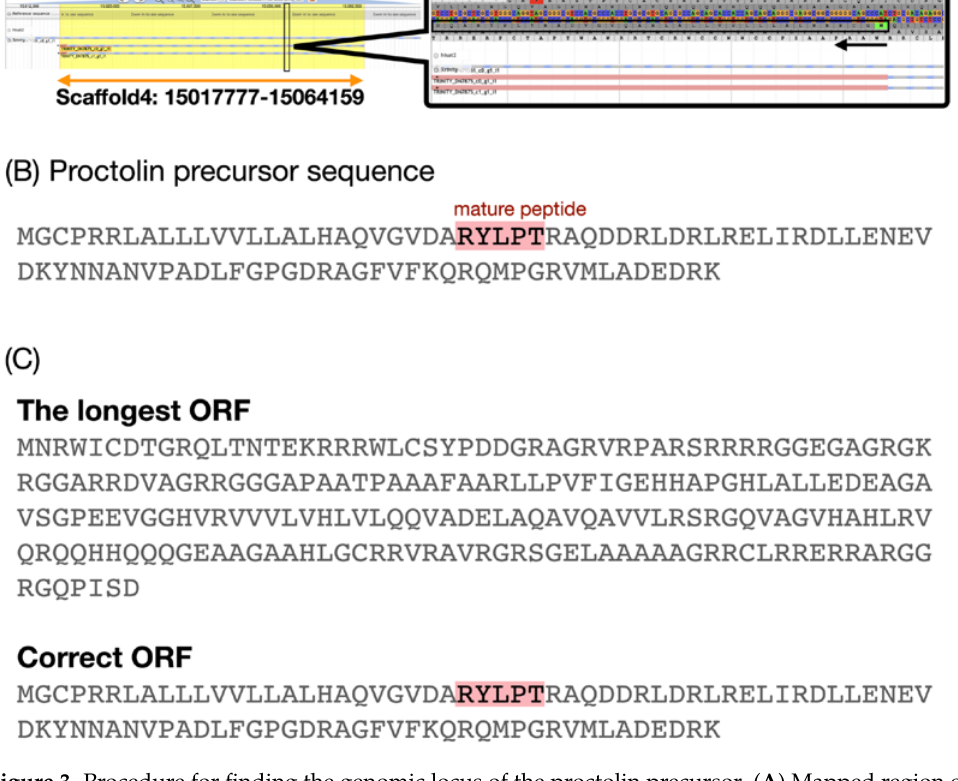
Figure 3. Procedure for finding the genomic locus of the proctolin precursor. ( A ) Mapped region of proctolin cDNA. ( B ) The amino acid sequence of the proctolin precursor. ( C ) The translated amino acid sequences with different reading frames from the mapped region.